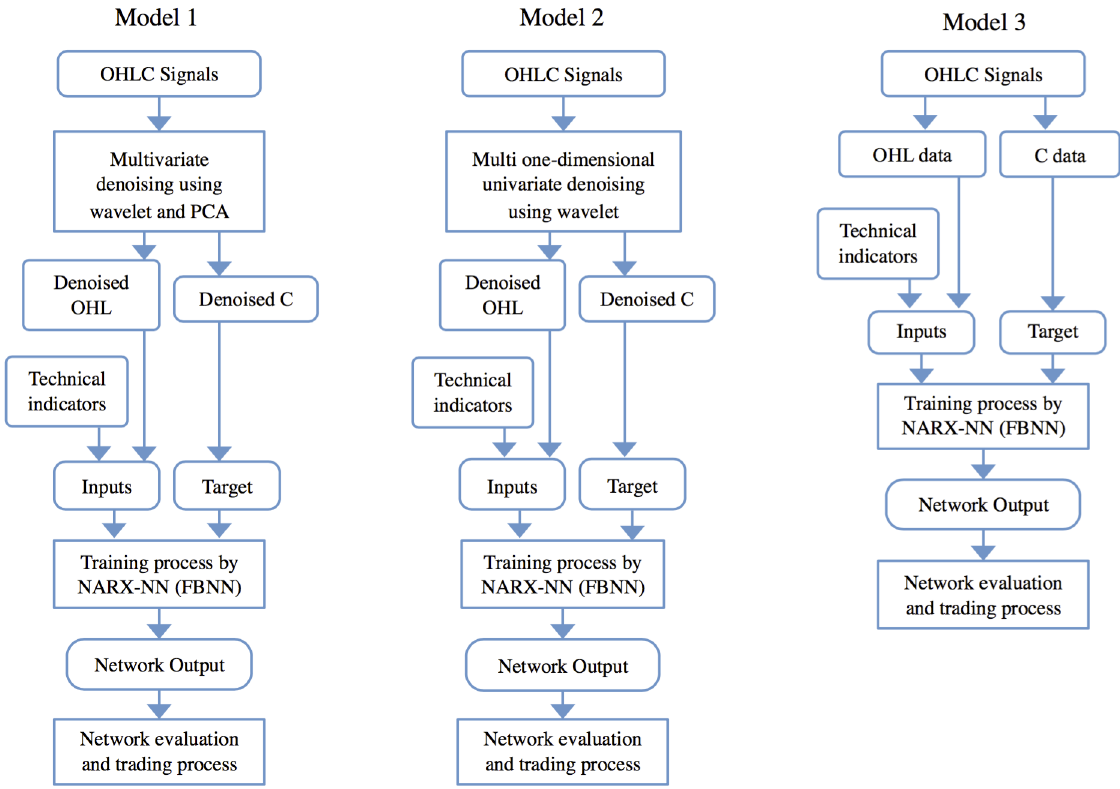
Fig 3. Architecture of the proposed